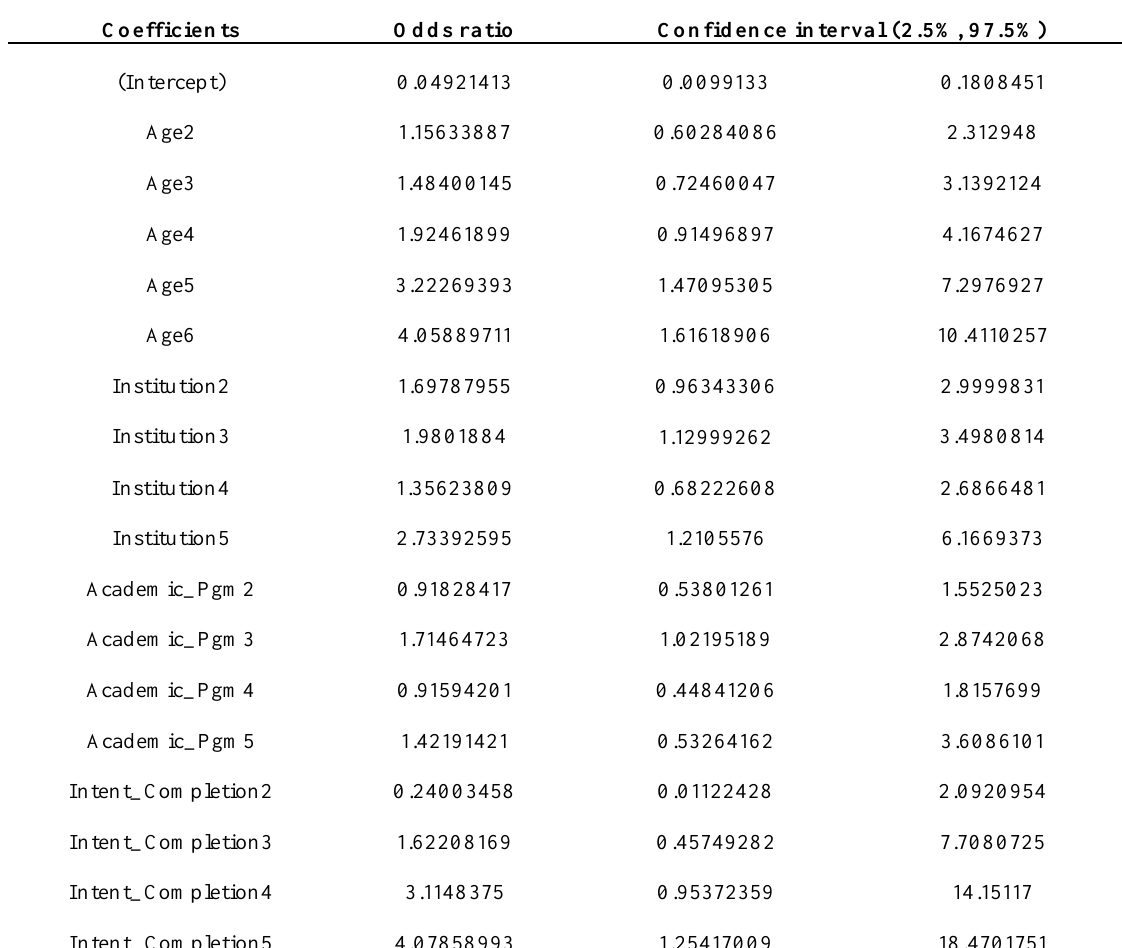
Odds Ratio of Multiple Binomial Logistic Regression Coefficients in Model 3 Coefficients Odds